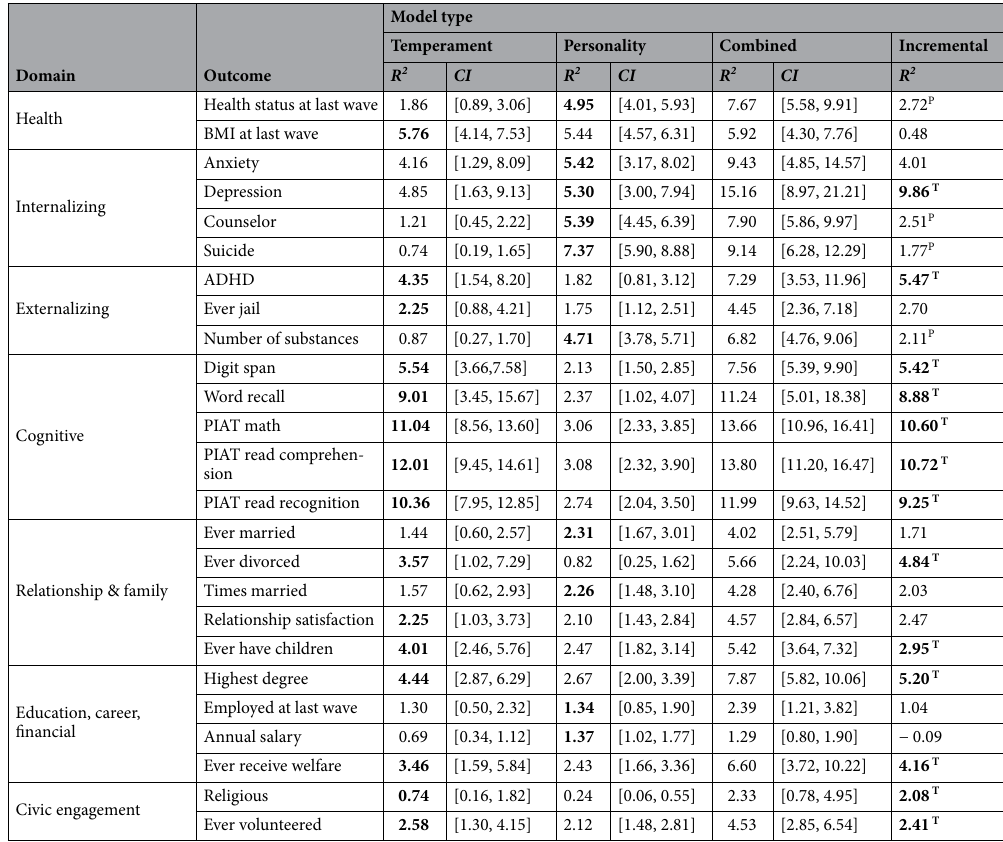
Table 1. Incremental and model R 2 values from temperament-only, personality-only, and combined models for all outcomes. R 2 values are presented as percentages. Results are from models without covariates. The incremental model R 2 is the percentage of the combined model R 2 not accounted for by adult-based personality (i.e., has personality model R 2 subtracted out). Bold values indicate the larger R 2 value between the temperament-only and personality-only models for each outcome. In the “Incremental” column, if the combined and personality-only R 2 credible intervals did not overlap, then temperament was a meaningful predictor above and beyond personality in terms of incremental predictive validity (these values are marked by a T superscript). Alternatively, if the combined and temperament-only R 2 credible intervals did not overlap, then personality was a meaningful predictor above and beyond temperament (these values are marked by a P superscript). To ease in readability, values in the “Incremental” column indicate outcomes for which temperament explained incremental variance are also